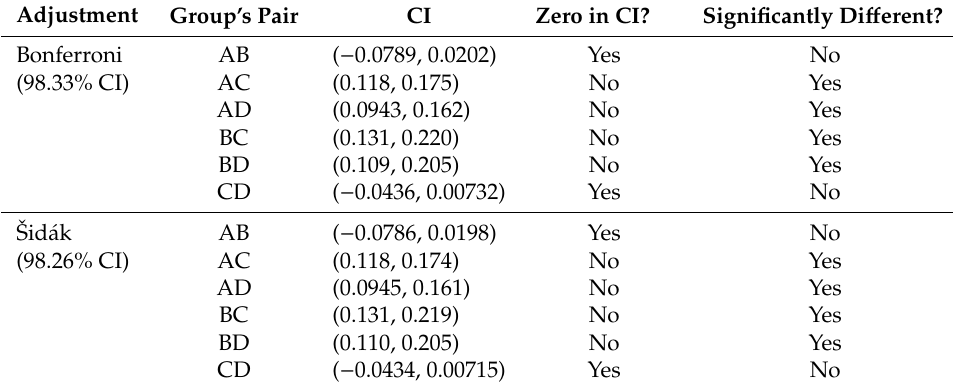
Table 5. mWald.2 method for an overall 90% CIs (i.e., Bonferroni 98.33% CI or Šid á k 98.26% CI for each group’s pair) for North Carolina under-reported tra ffi c accident